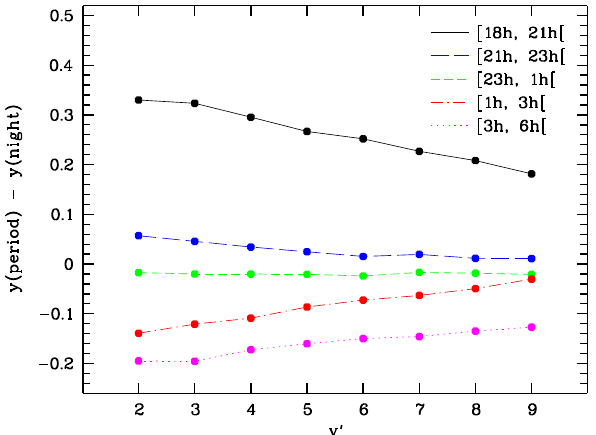
Figure 11. Vibrational population ratio relative to the sample mean as a function of v (cid:48) for different local time periods. Data points for the same period are connected by lines of a fixed type and colour (see legend). All data points are based on the G98 line parameters. The y values were derived from the intensities of all measured lines. The errors of the plotted mean values are of the order of 0.04.